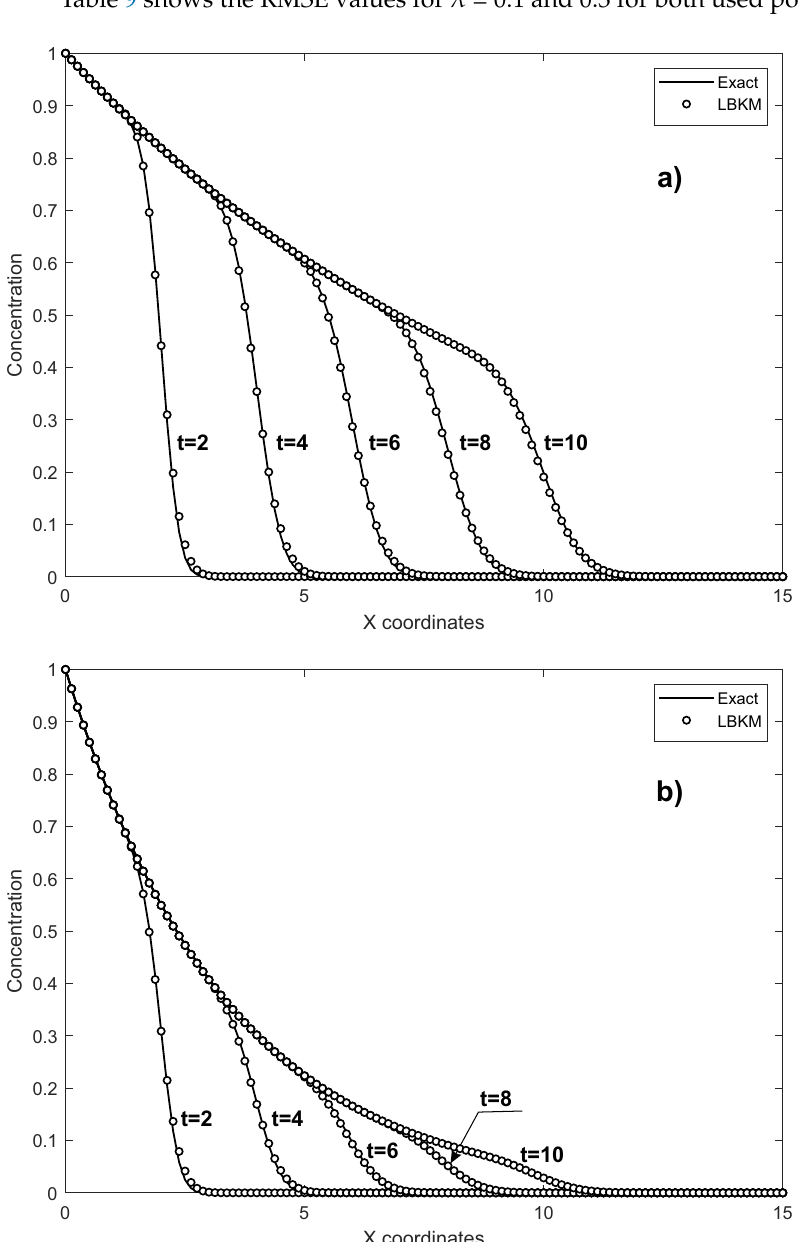
Figure 15. Example No. 3—concentration profiles for Pe = 1000, mesh 161 × 33: ( a ) λ = 0.1, ( b ) λ =